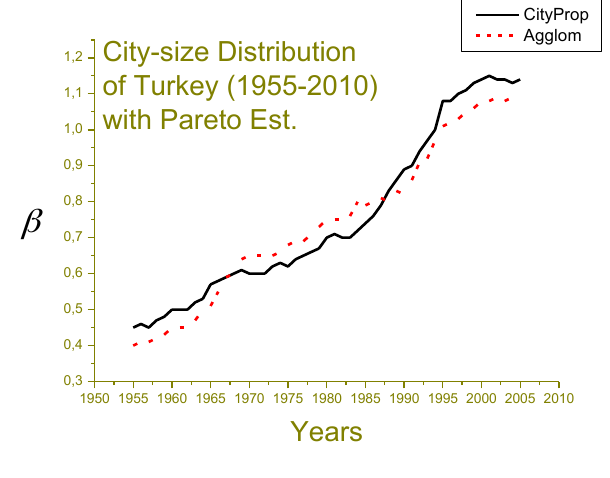
Graphic 2: City-size distribution of Turkey with Hill